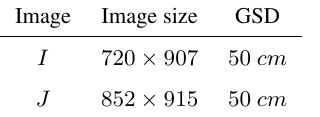
Table 1: The specifications of the used image samples of Munich city, the images’ sizes and Ground Sampling Distance (GSD).